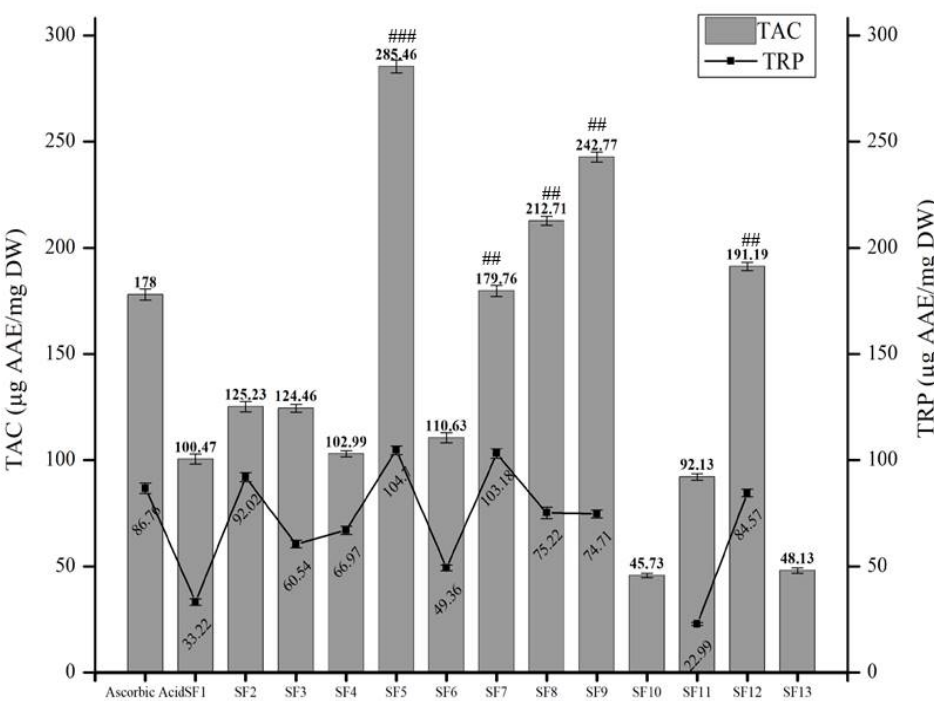
Figure 3. Ascorbic acid equivalent (AAE) antioxidant values, expressed as µg/mL. The symbol ### indicates the significance of results where p < 0.01, ## p < 0.05.